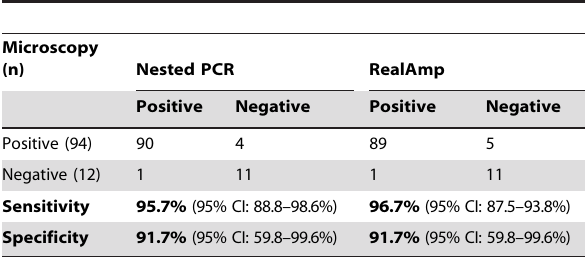
Table 4. Cost analysis of the RealAmp method compared to the nested